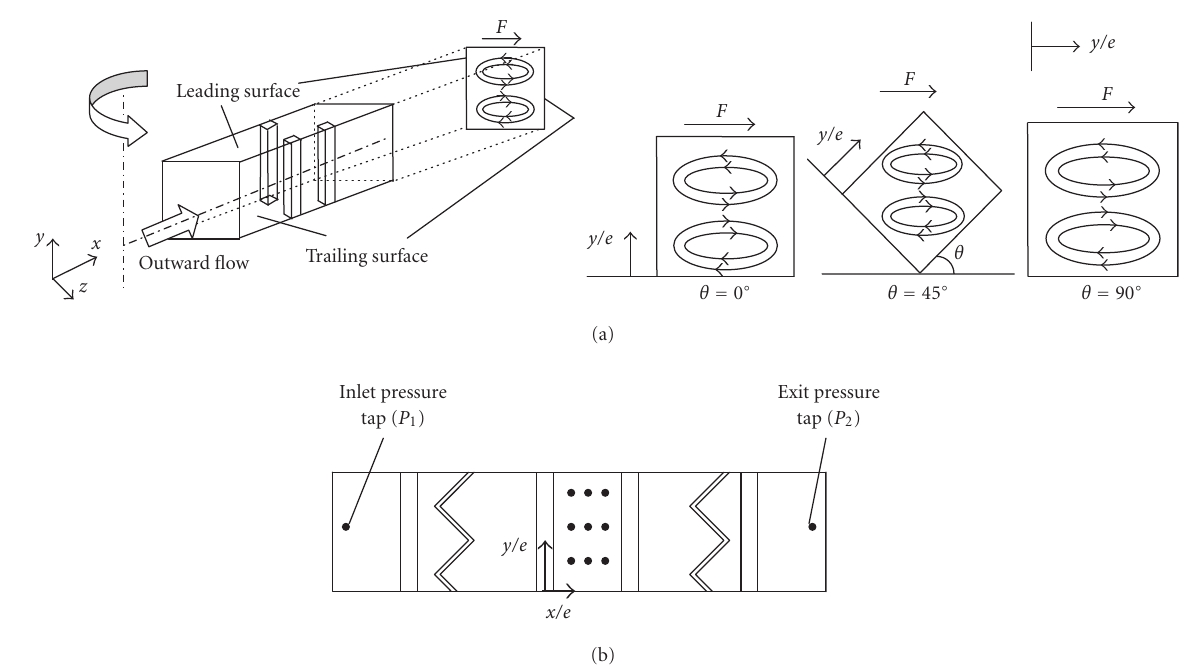
Figure 2: (a) Three-dimensional sketch of the test section along with the definition of orientation angle. (b) Sketch showing the static pressure tap locations.